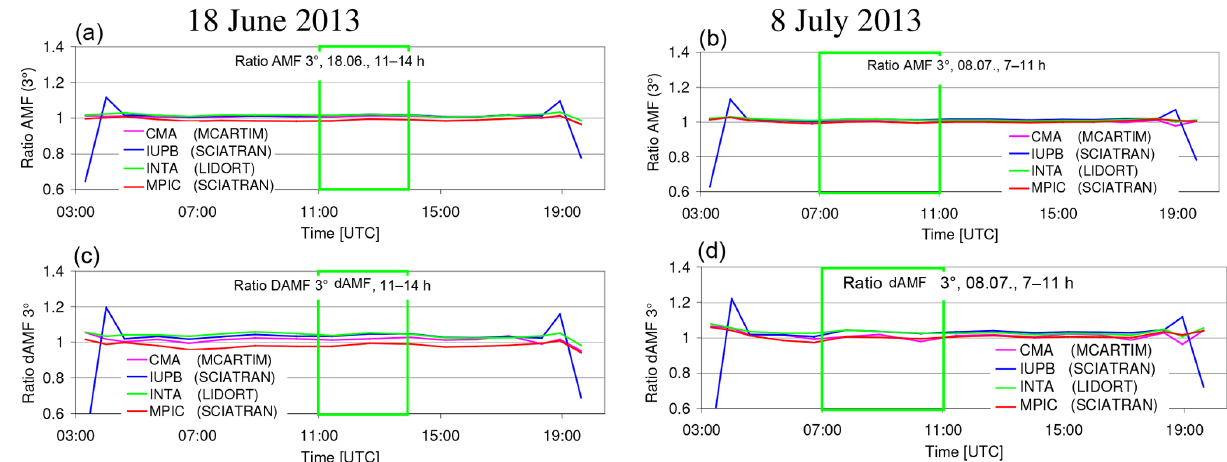
Figure A13. Ratios of the O 4 AMFs (a, b) and O 4 dAMFs (c, d) simulated by different groups using different radiative transfer models vs. those for the MPIC simulations using McArtim for both selected days.